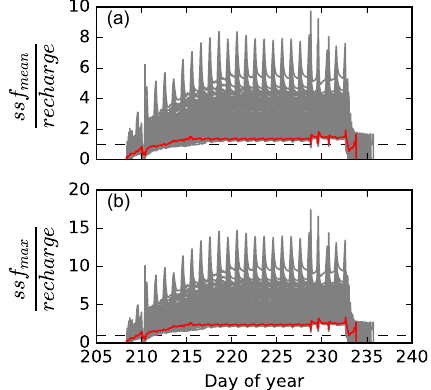
Figure 10. Simulated ratios of (a) average subsurface flow and recharge fluxes, and (b) maximum subsurface flow and recharge fluxes for the 308 behavioral parameter sets based on lateral sub- surface flow and δ 2 H. The red line shows the result of Model 2 using the best parameter set in Table